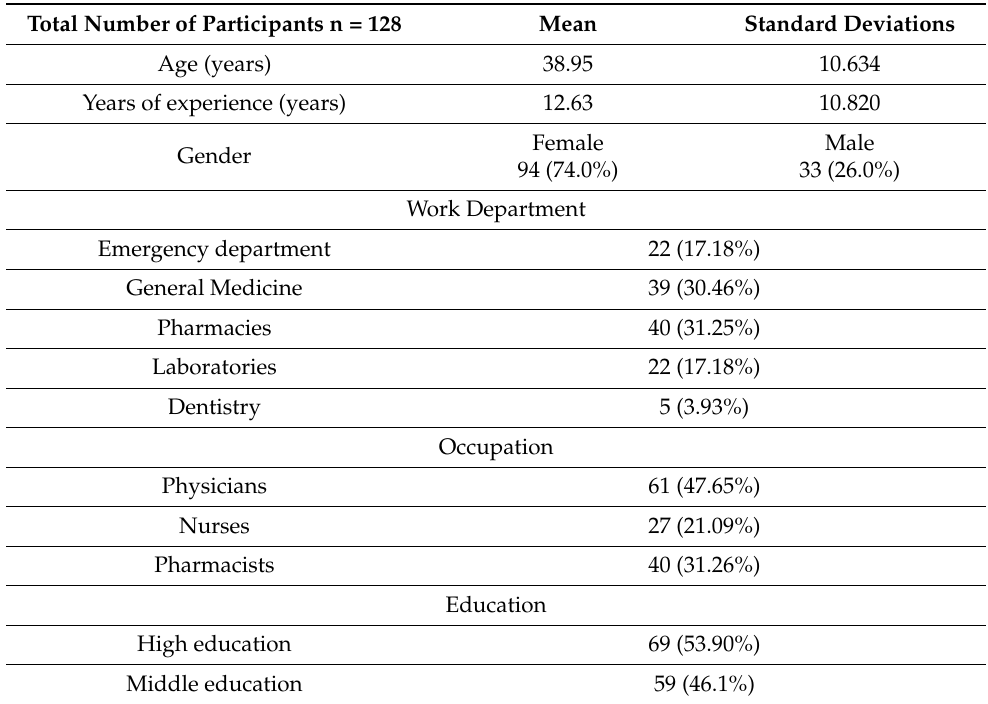
Table 2. Basic demographic characteristics of study population.